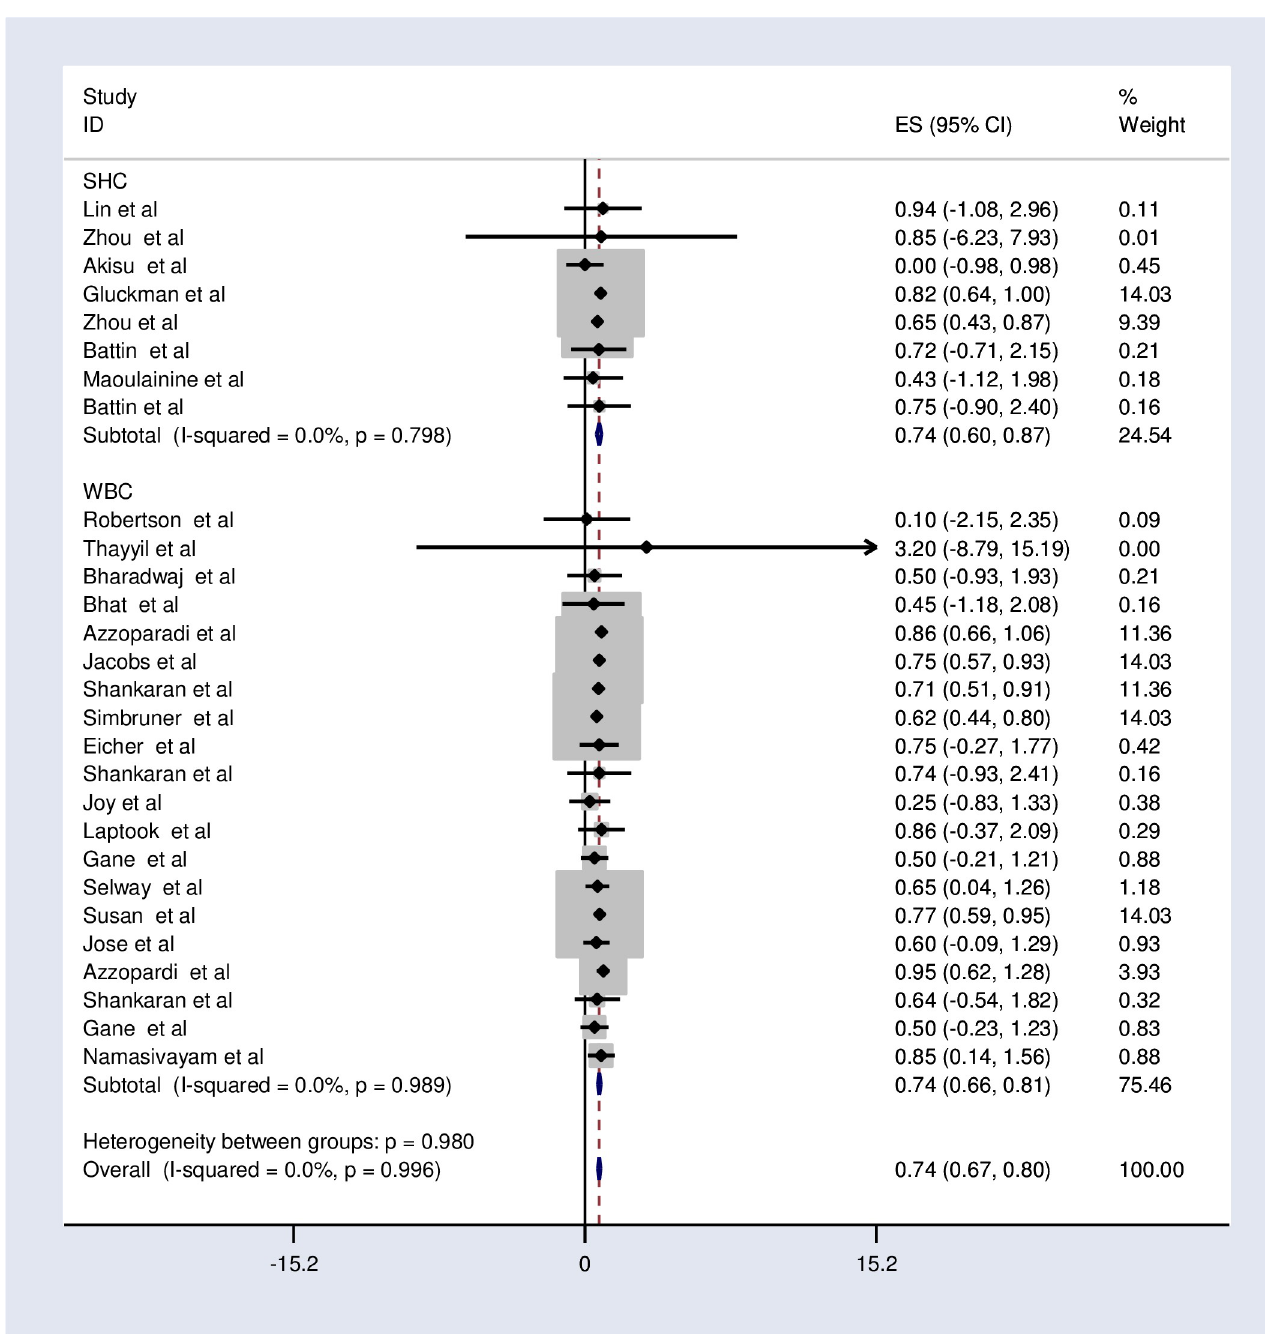
PLOS ONE | https://doi.org/10.1371/journal.pone.0247229 February 25,